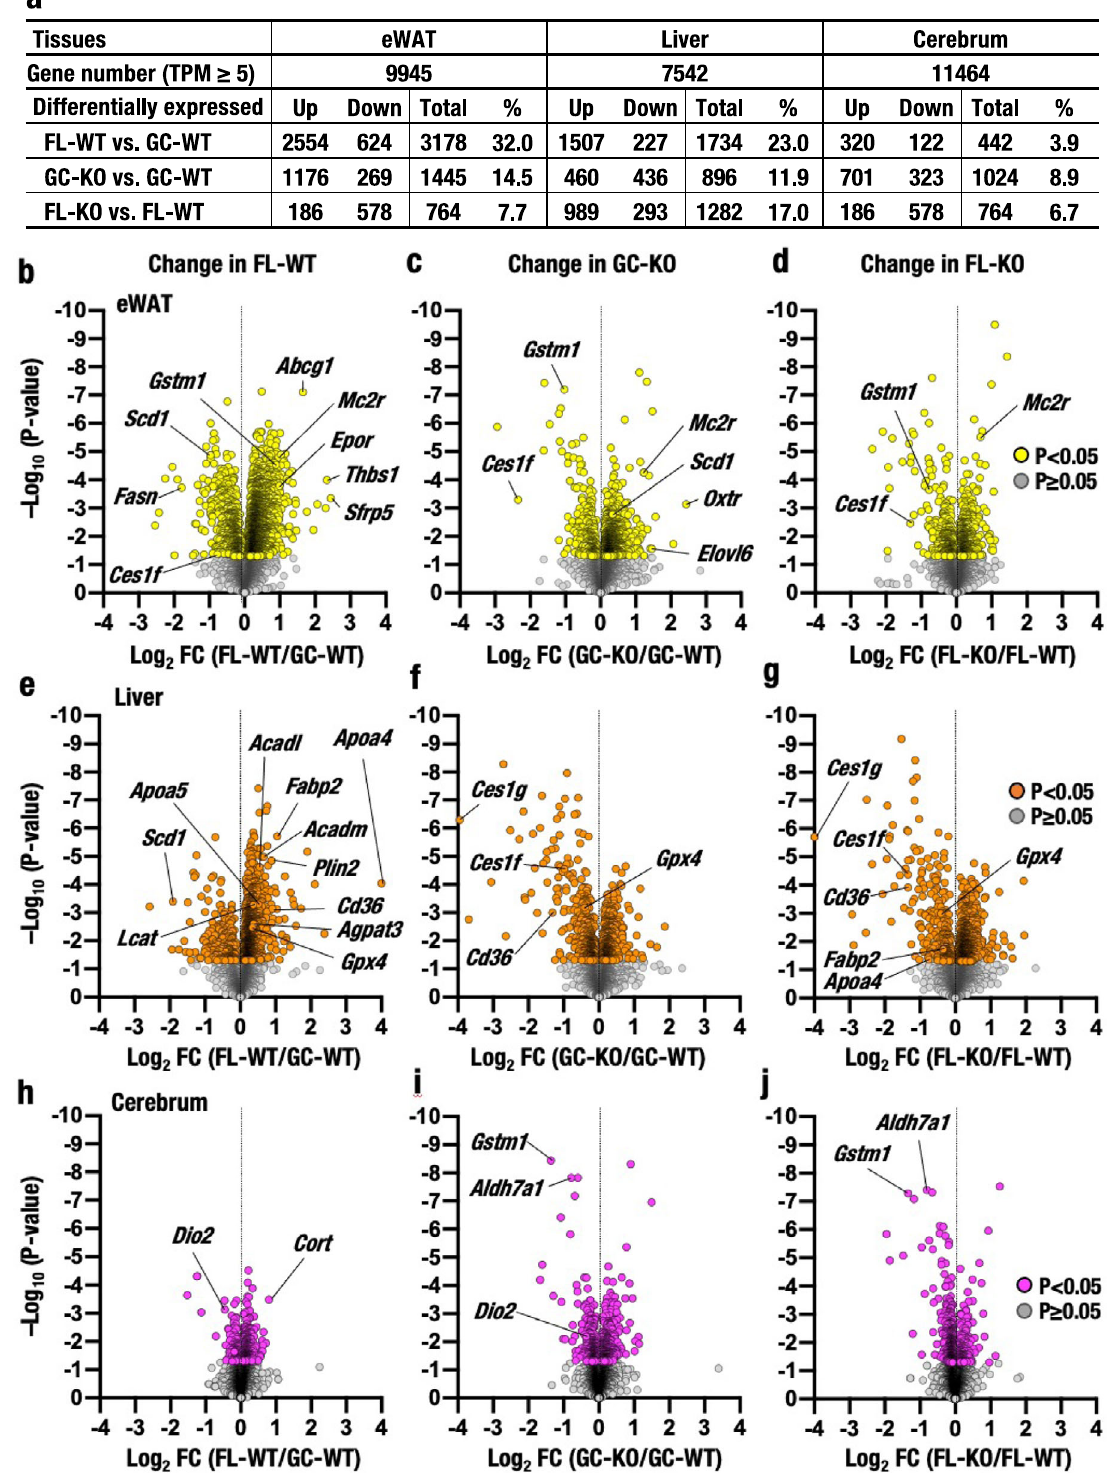
Fig. 6 RNA-seq analyses of the eWAT, liver and cerebrum. a Numbers of total genes (mean TPM value ≥ 5) and differentially expressed genes ( P < 0.05 according to the two-tailed test) identi fi ed in RNA-seq analyses of the eWAT, liver and cerebrum of GC-WT ( n = 6), FL-WT ( n = 6), GC-KO ( n = 6) and FL-KO ( n = 5) mice. b – j Volcano plots of RNA-seq analyses. The x-axis represents the log 2 fold change (FC) in the eWAT ( b – d ), liver ( e – g ) and cerebrum ( h – j ) of FL-WT mice compared to GC-WT mice ( b , e , h ), GC-KO mice compared to GC-WT mice ( c , f , i ) and FL-KO mice compared to FL-WT mice ( d , g , j ). The y-axis represents the negative log 10 of the two-tailed P value. Vertical dotted lines denote a fold change of one. Yellow ( b – d ), magenta ( e – g ) and orange ( h – j ) dots denote P < 0.05, and grey dots denote P ≥ 0.05 ( b – j